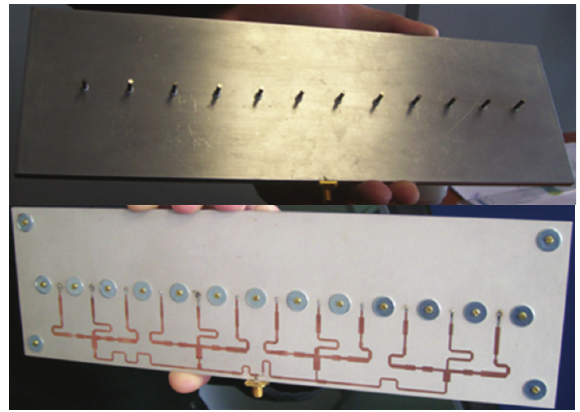
Figure 7: Top view of the manufactured prototype and back view with the feed distribution network.